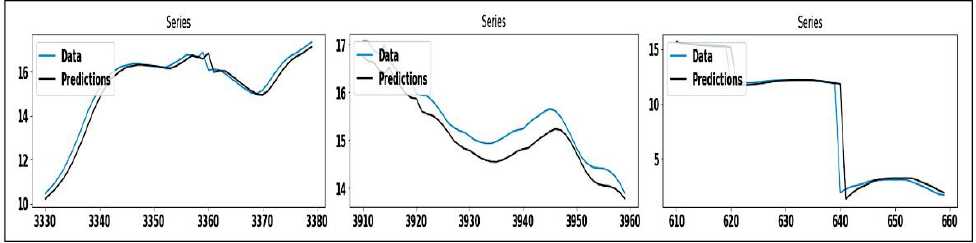
Figure 25. The wind speed prediction using the GAS model on dataset #1 [21].